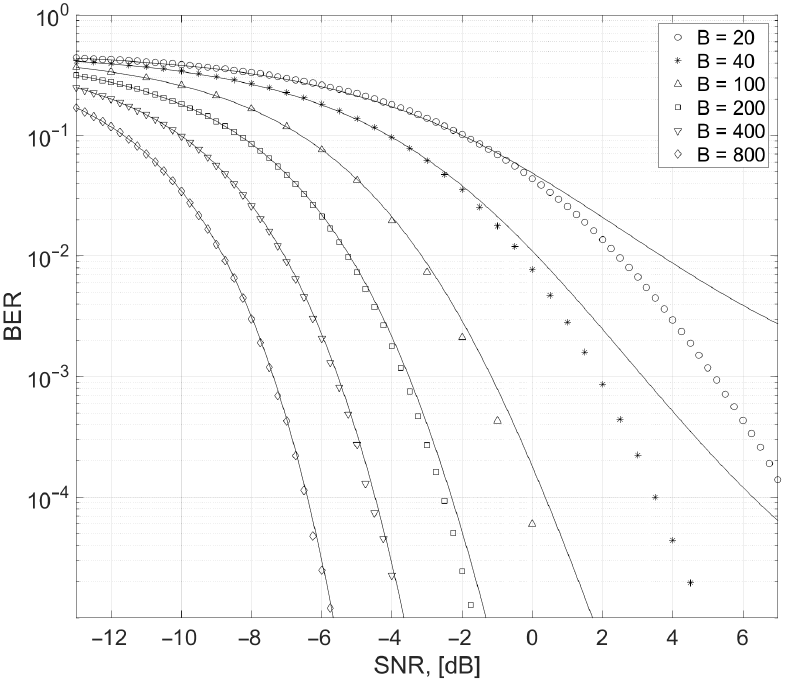
Figure 4. BER as a function of SNR and processing gain B . Solid lines correspond to simulation; dotted curves to analytical estimates